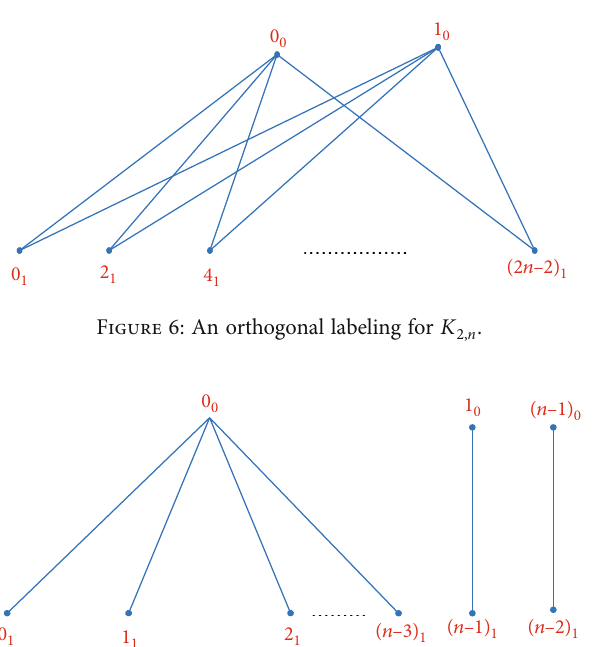
Figure 7: An orthogonal labeling for 2 K